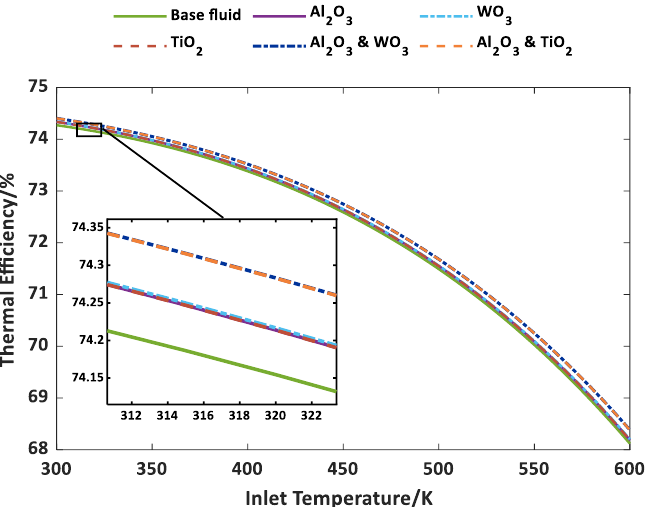
Figure 4. Thermal efficiency with various inlet temperatures for different mono and hybrid nanofluids.